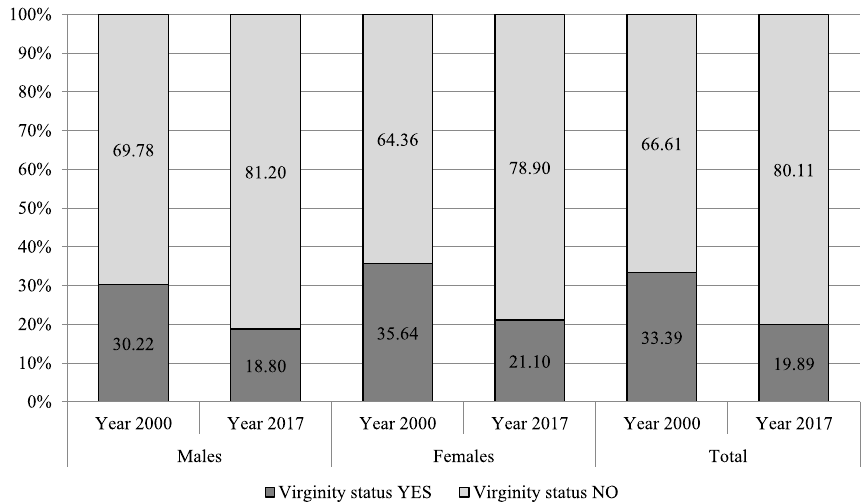
Fig. 1 Distribution of virginity by gender and